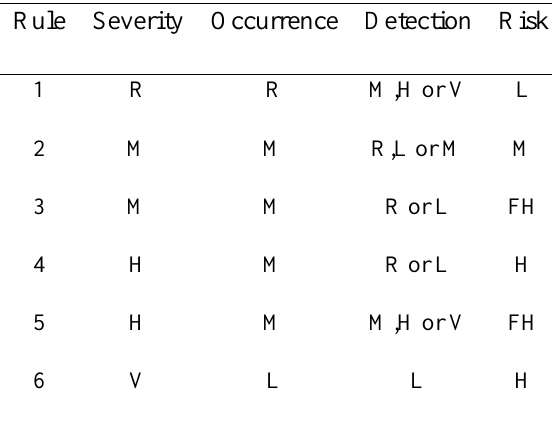
Table 3. Specified fuzzy